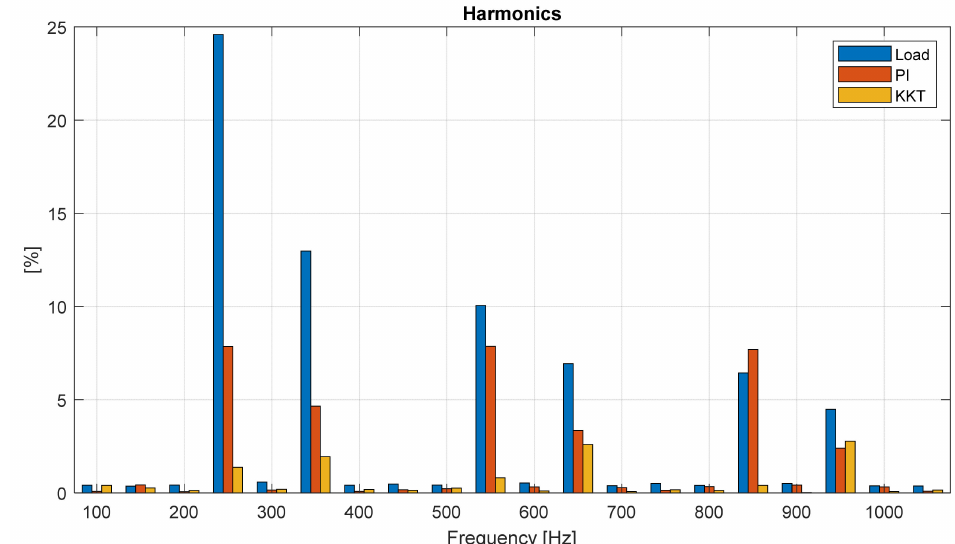
Figure 13. The currents spectra of the selected phase (up to 1 kHz): blue—the load current; red—the grid current for the PI optimal controller; yellow—the grid current for the KKT